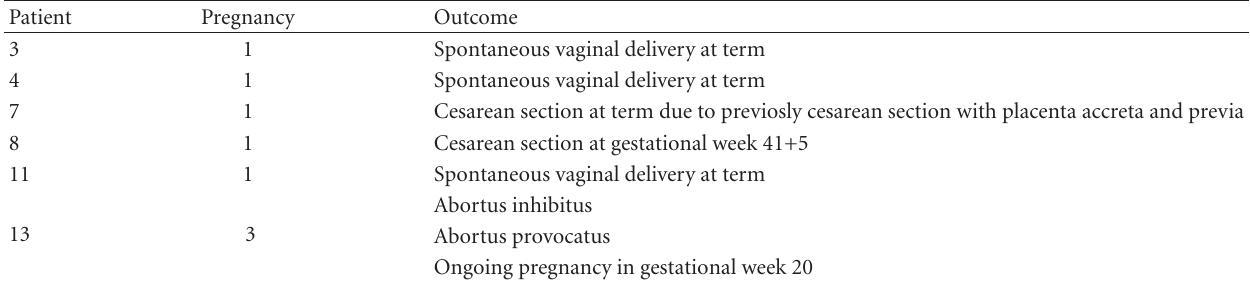
Table 2: Outcome of pregnancies two years after clinical